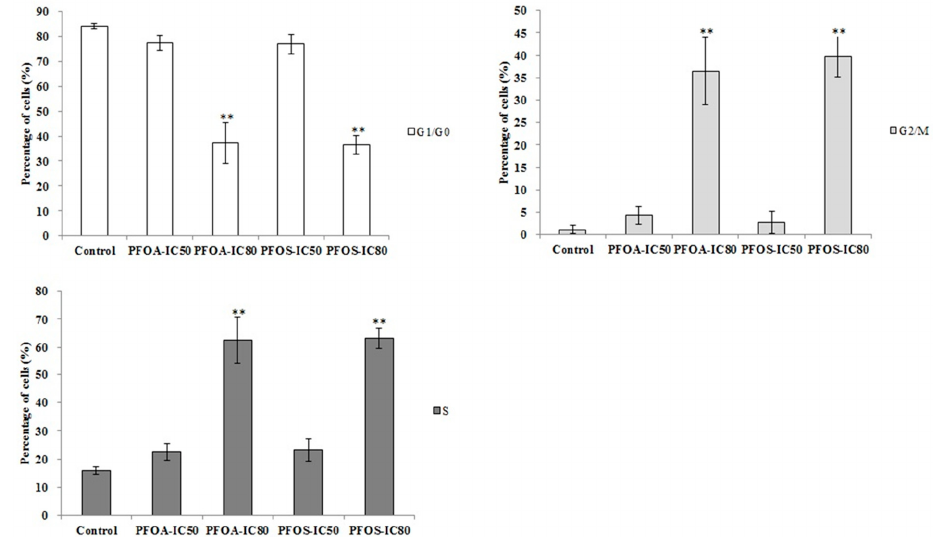
Figure 4. Cell cycle of ZFL under the inducing of PFOA and PFOS. The experiment was repeated three times. ** p < 0.01.